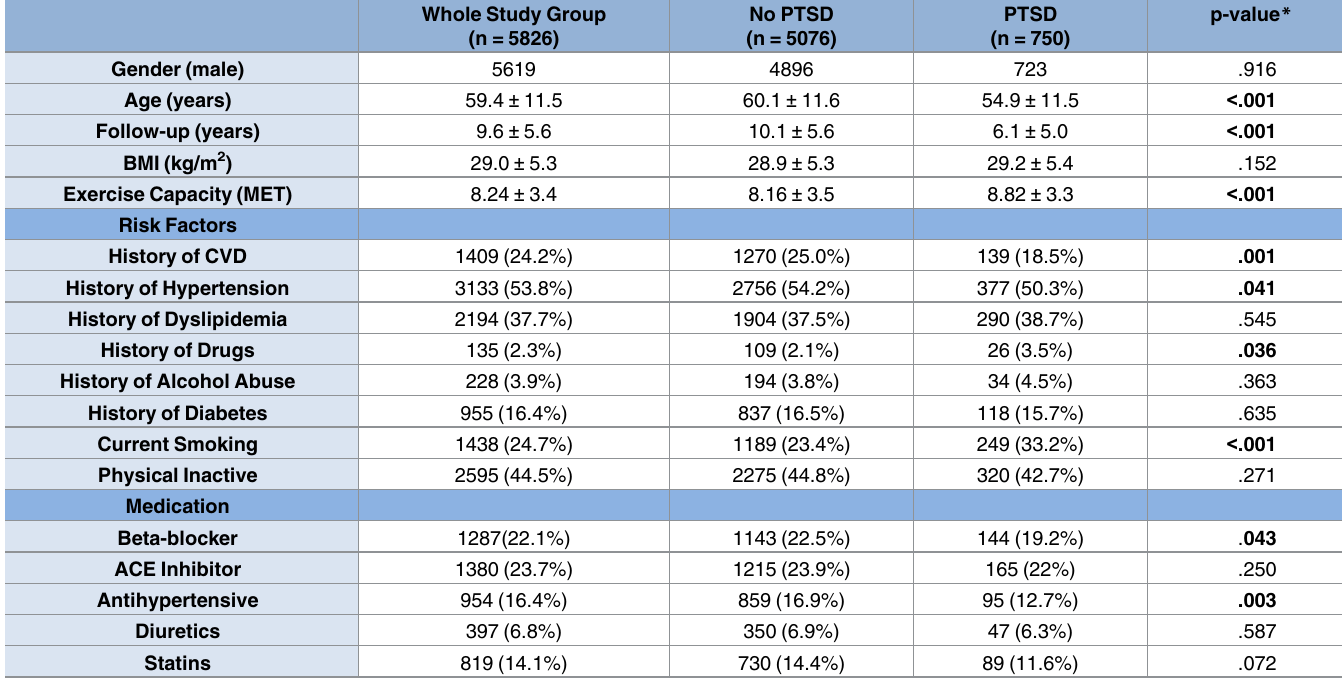
Table 1. Patients characteristic.